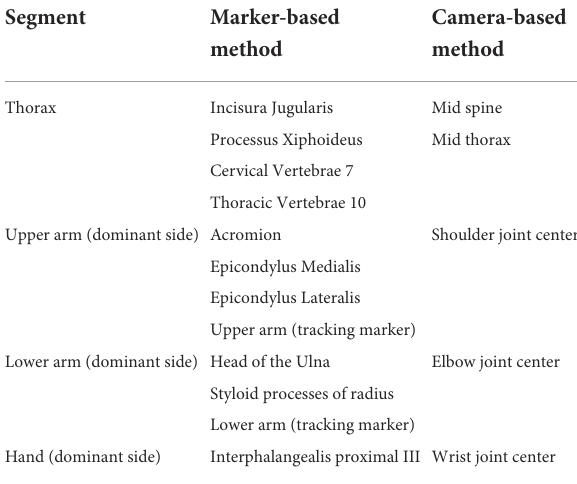
TABLE 1 Anatomical locations of markers/coordinates used per